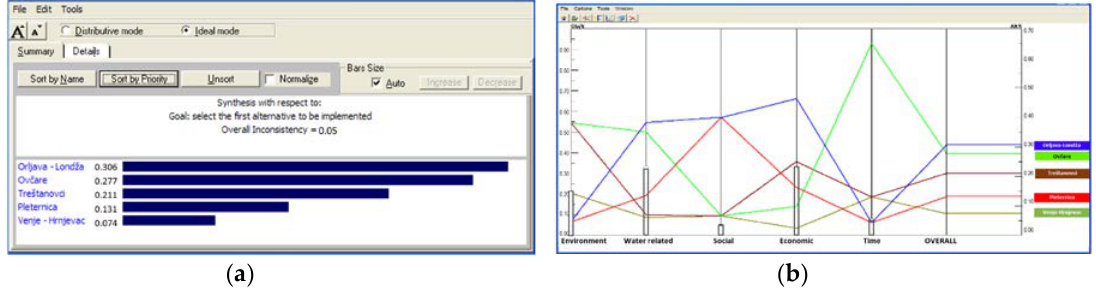
Figure 5. AHP results based on pairwise assessment of criteria and alternatives for Scenario 1: ( a ) the final ranking, and ( b ) graphical presentation of all alternatives assessment by each group of criteria.